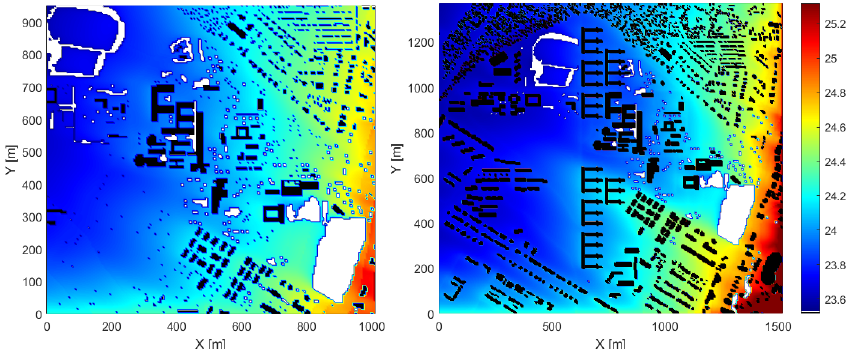
Figure 14. Air temperature [°C] at pedestrian level: on the left, in the current situation; on the right, in the planned situation.